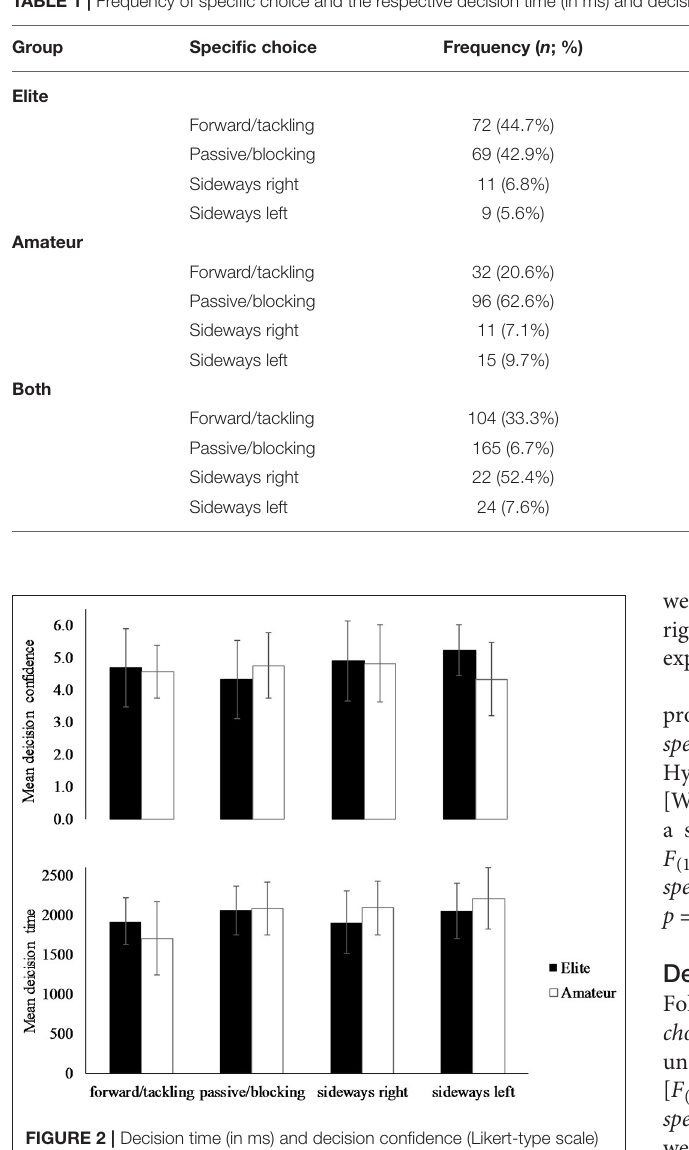
FIGURE 2 | Decision time (in ms) and decision confidence (Likert-type scale) of specific choices of elite and amateur players. Error bars indicate standard